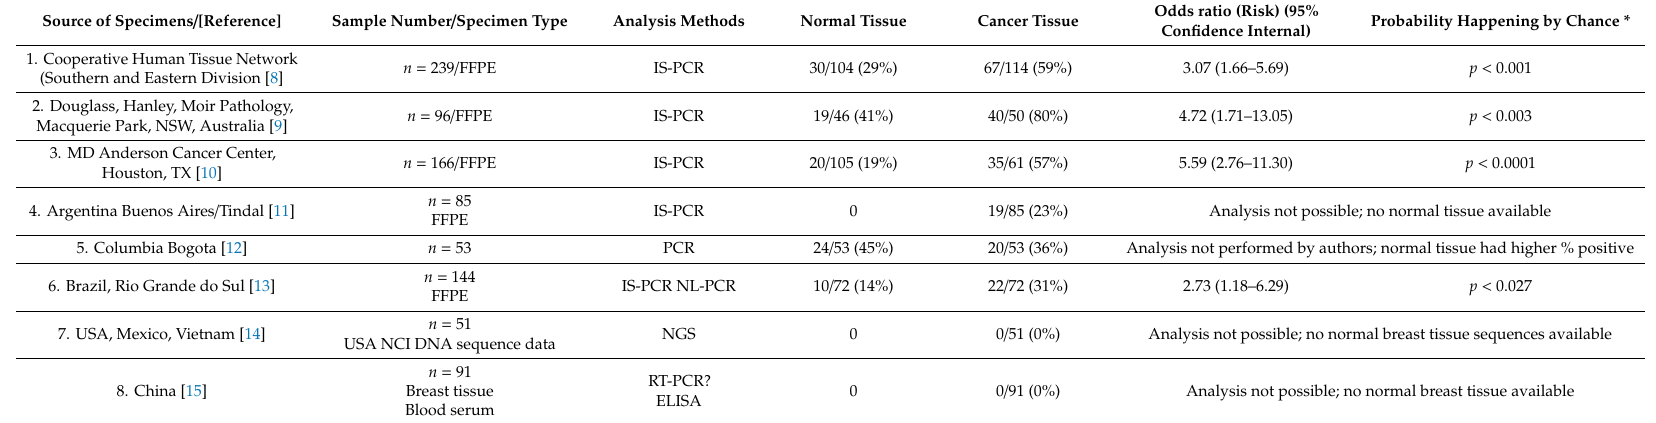
Table 1. Hill Criterion #1: There should be a strong relationship between causative agent and disease in question. Source of Specimens /